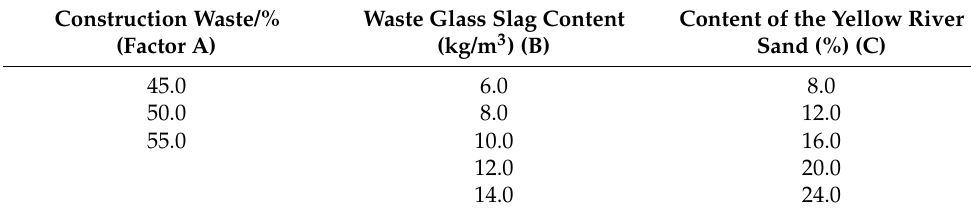
Table 6. Orthogonal test factor level table.